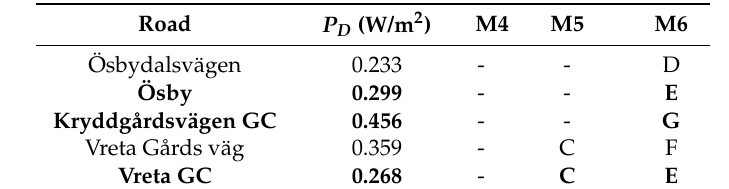
Table 5. Classification in accordance with the Road Lighting Energy Efficiency Classification (RLEEC) [18] for different M-classes (M4–M6), based on P D , installed power density (W/m 2 ). M-classes shown are restricted by the minimum class for which the requirements were fulfilled (based on fulfilment of classes shown in Table 4). A = the most energy efficient, G = the least energy efficient. “GC” and bold letters indicate pedestrian and bicycle